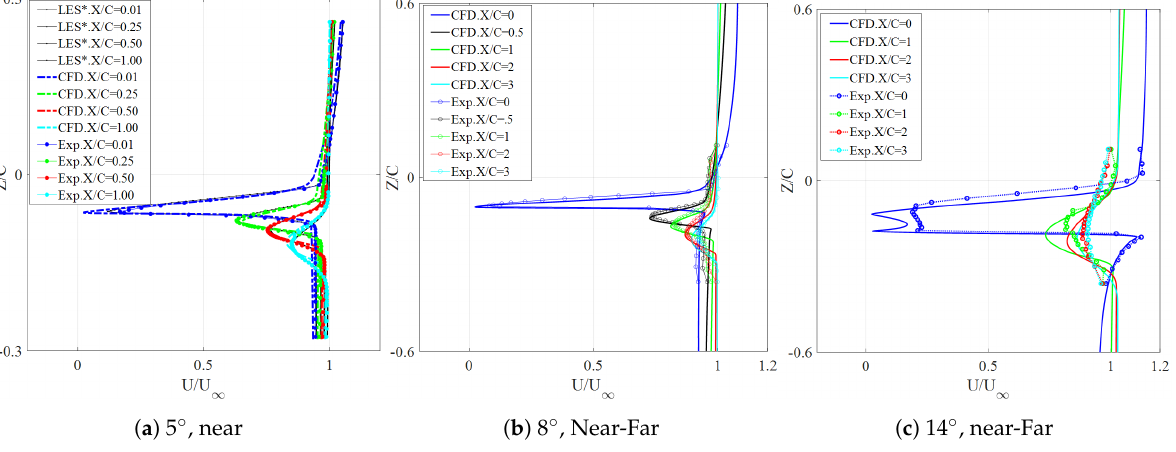
Figure 9. Velocity characteristics at selected AOA: CFD 3D vs. HW. CFD and LES corroborate the wind-tunnel data, and LES ∗ shows NACA4412 in an unconfined domain at AOA = 5 ◦